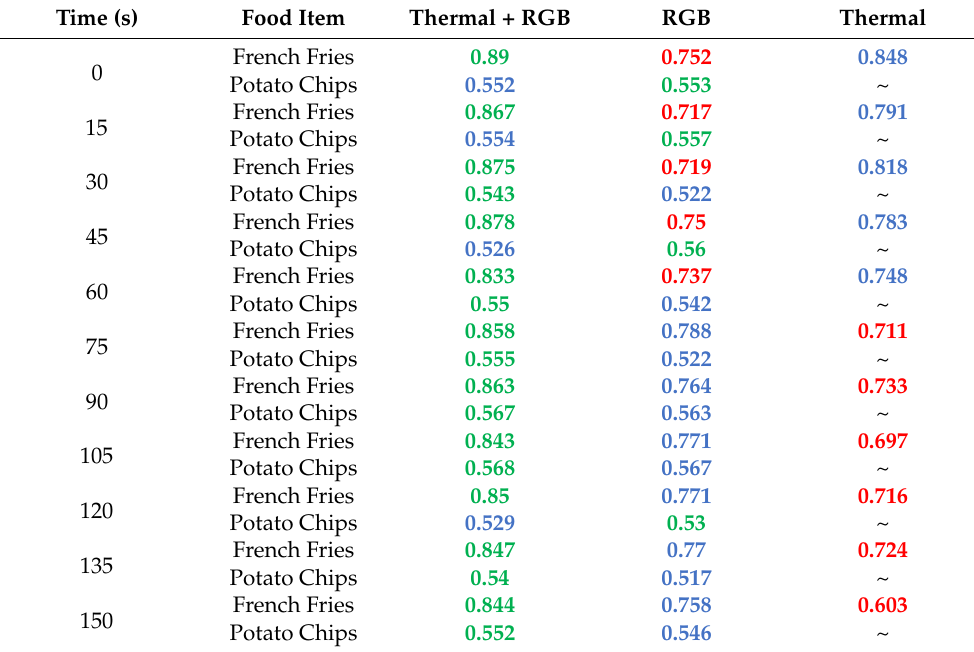
Table 3. Segmentation Results (Temporal Dataset): F1